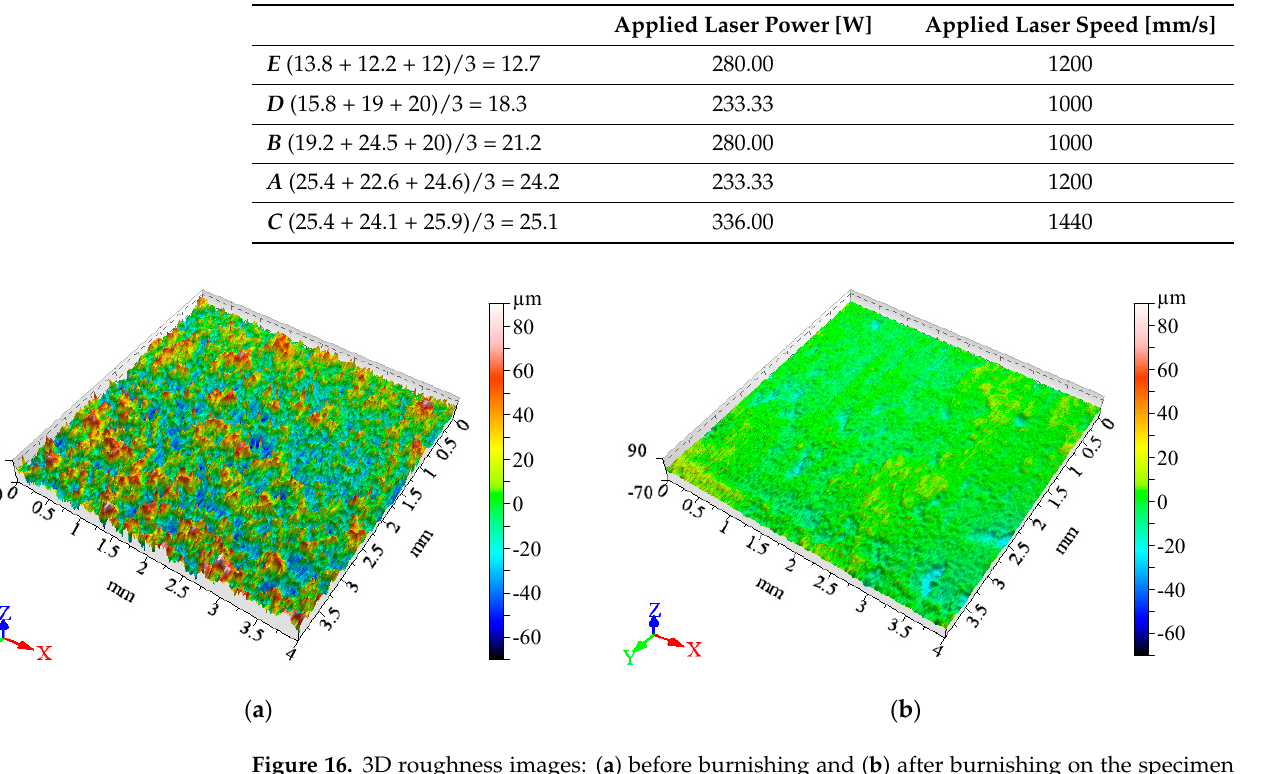
Table 14. Improvement ratio indices on cylinders manufactured with different rapid prototyping technologies for S a , S z and S q .